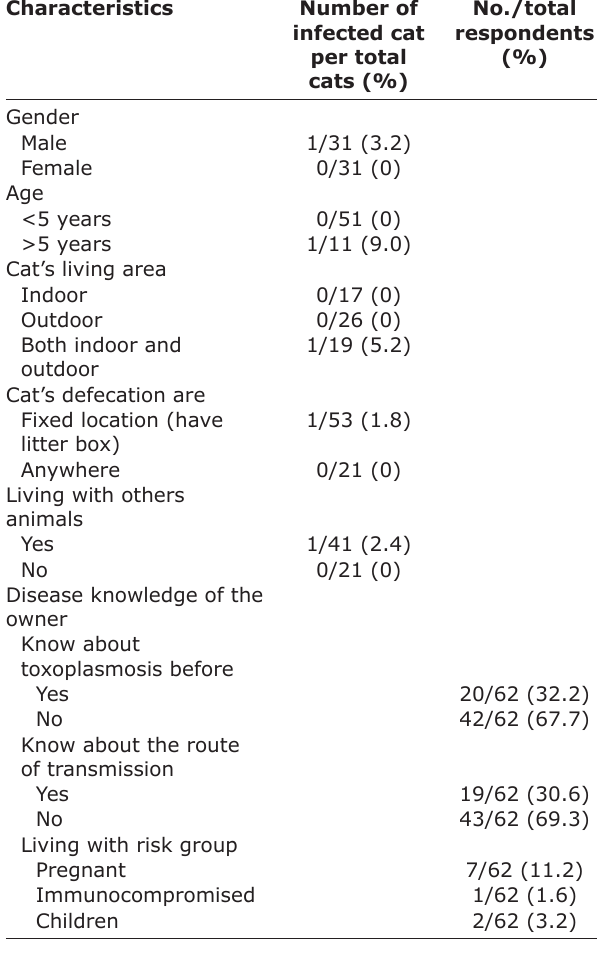
Table-3: Demographic information of cats and their owner retrieved from the questionnaire (owned cats, n =